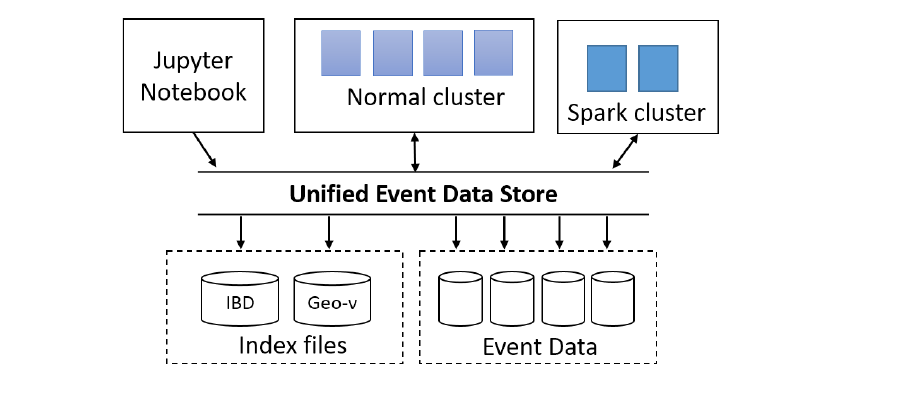
Figure 3. The unified event data store